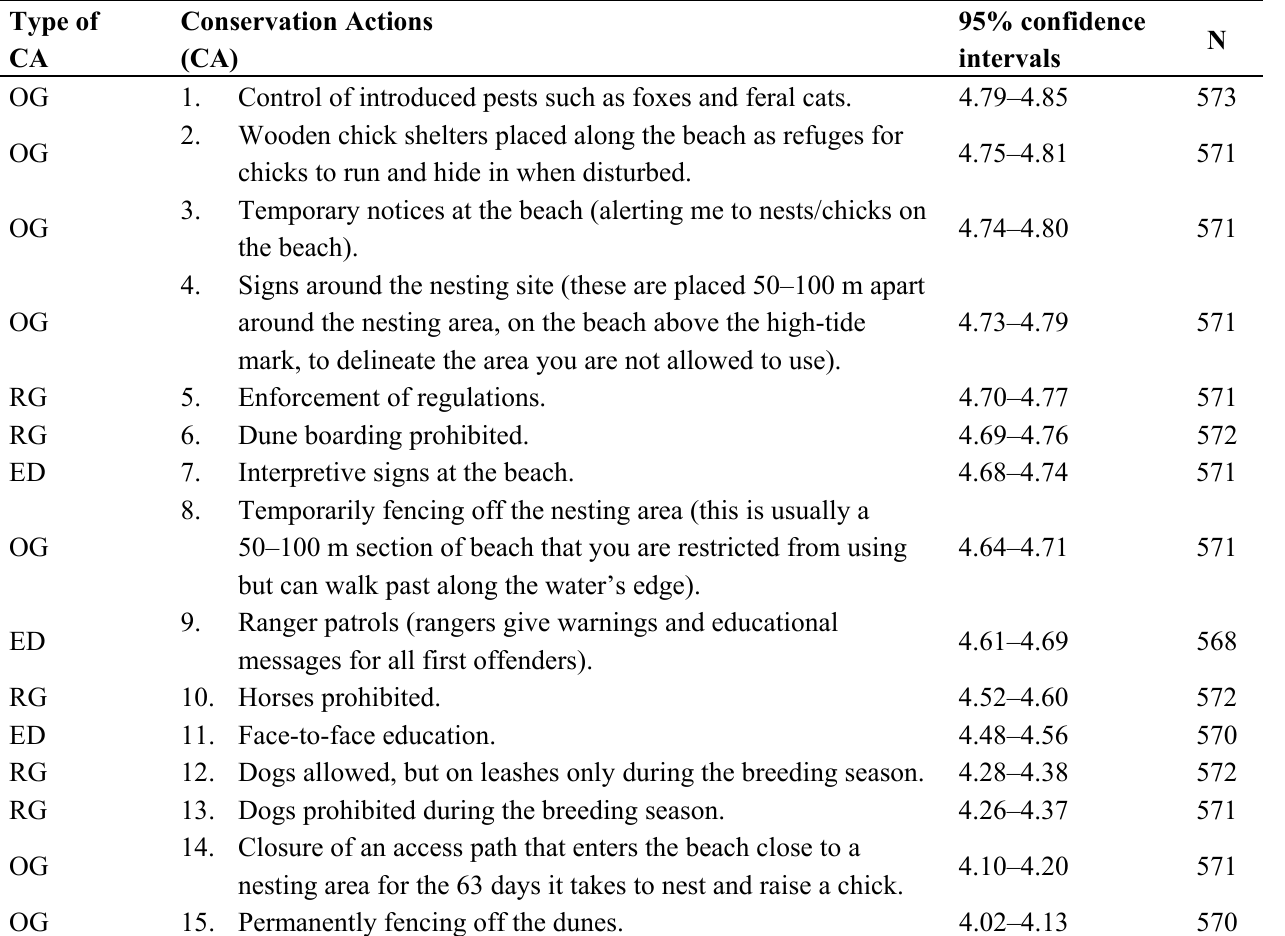
Table 1. Respondent ratings of the degree of inconvenience perceived in relation to 15 conservation actions rated on a scale from 1 (“I don’t like it/it will inconvenience me greatly”) to 5 (“I like it/it is no inconvenience to me”). Conservation actions are